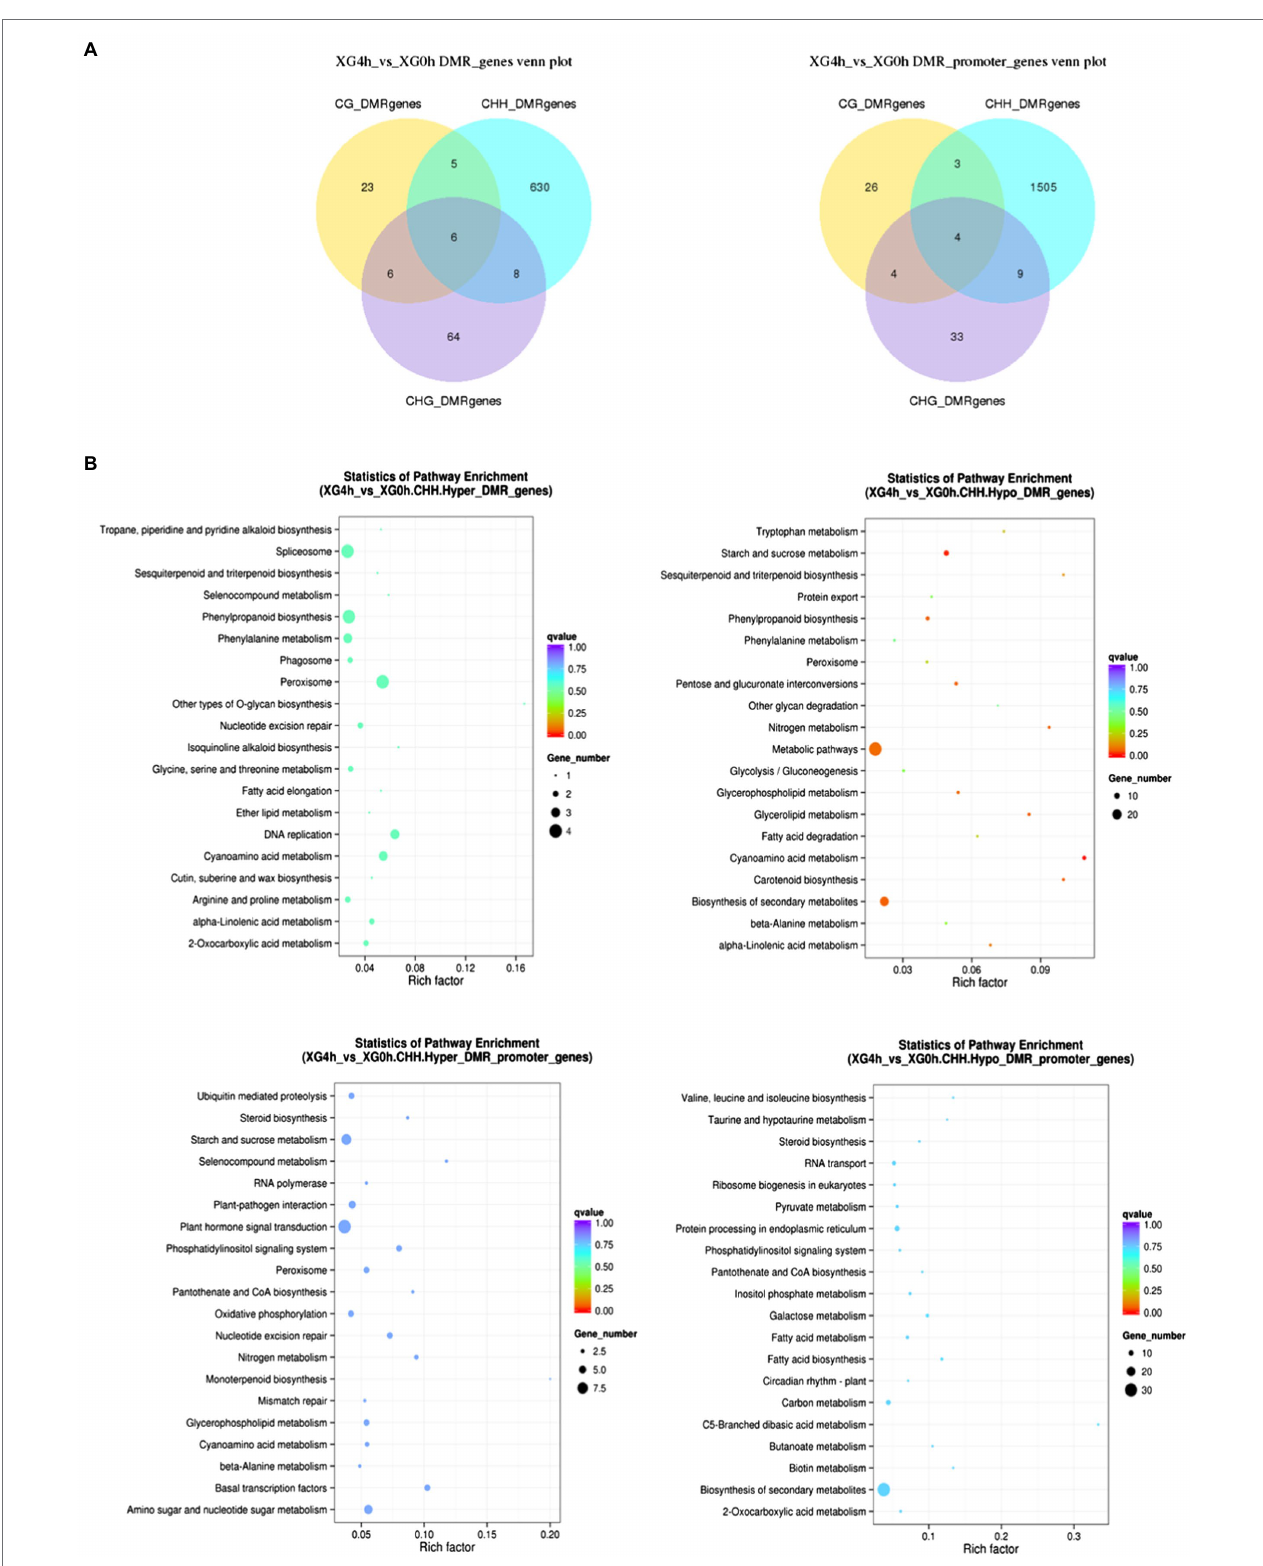
FIGURE 5 | Analysis of differentially methylated genes under osmotic stress. (A) Venn diagram between DMGs in different contexts. (B) KEGG enrichment pathway of DMGs in CHH